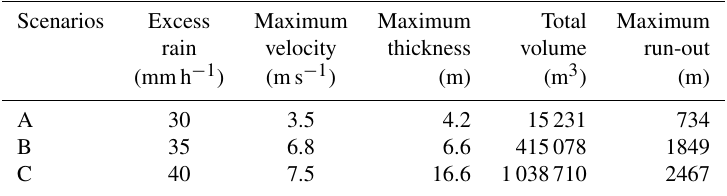
Table 6. Statistics summary for scenarios A–C.